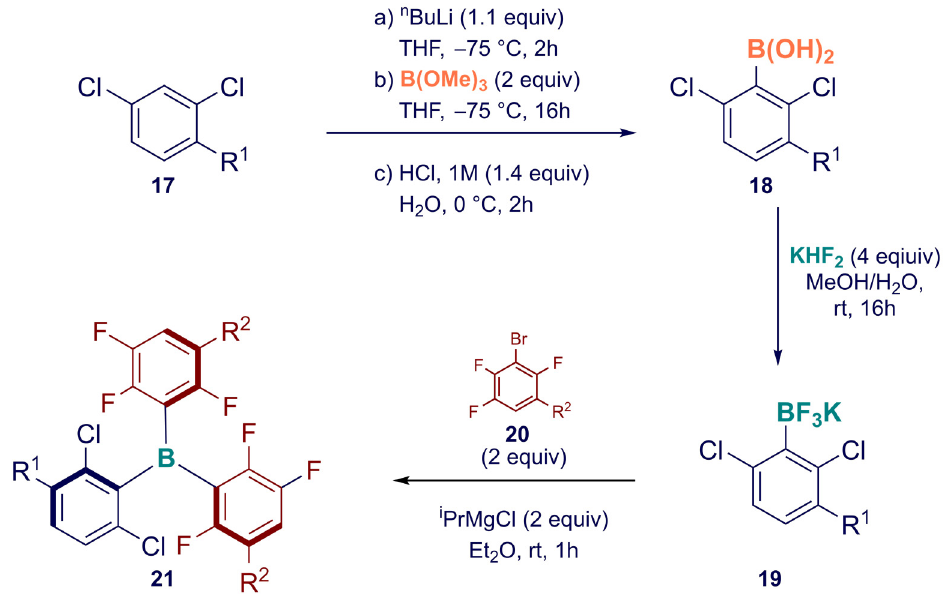
Scheme 5. Synthetic route for heteroleptic boranes bearing chlorinated and fluorinated aryl rings. The first example of halogenated triarylborane bearing three different aryl rings, B(C 6 F 5 )(C 6 Cl 5 )(3,5-(CF 3 ) 2 C 6 H 3 ) 27 , was synthetised from borane dimethylsulfide 22 five synthetic steps. First, a single equivalent of Li(C 6 F 5 ) was generated at − 78 ◦ C and was reacted with borane dimethylsulfide 22 to form [H 3 B(C 6 F 5 )]. The excess hydride was abstracted with TMSCl obtaining H 2 B(C 6 F 5 ) 23 . The trifluoromethyl bearing aryl ring was installed via a similar strategy by adding Li(3,5-(CF 3 ) 2 C 6 H 3 ) and abstraction of the